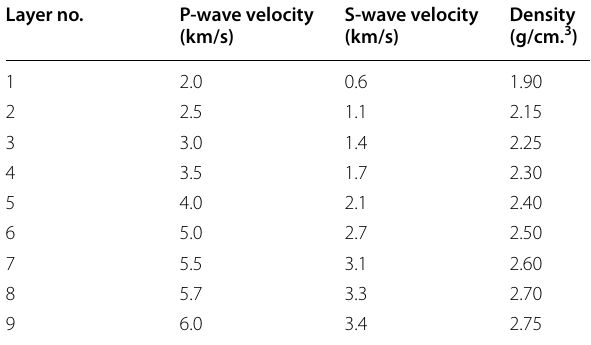
Table 2 Assumed P- and S-wave velocities and density for each layer Layer